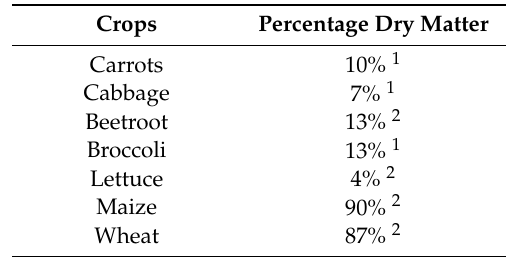
Table 3. Percentage crop dry matter used to convert Soil Water Balance model dry matter results to fresh mass.